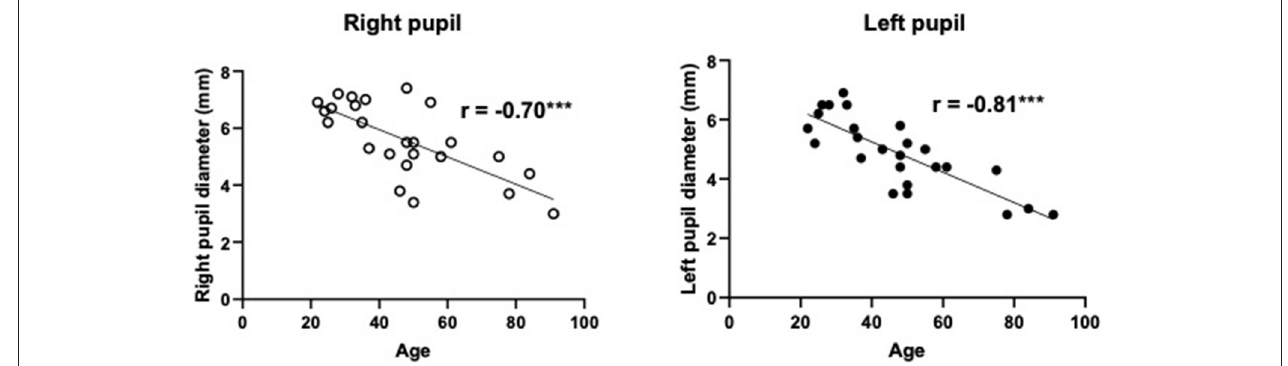
FIGURE 4 | The relationship between spontaneous pupil diameters and age in healthy volunteers. The pupil diameters were significantly smaller with increased age in both the right and left eyes. r , correlation coefficients. *** P < 0.001. N = 25/group.